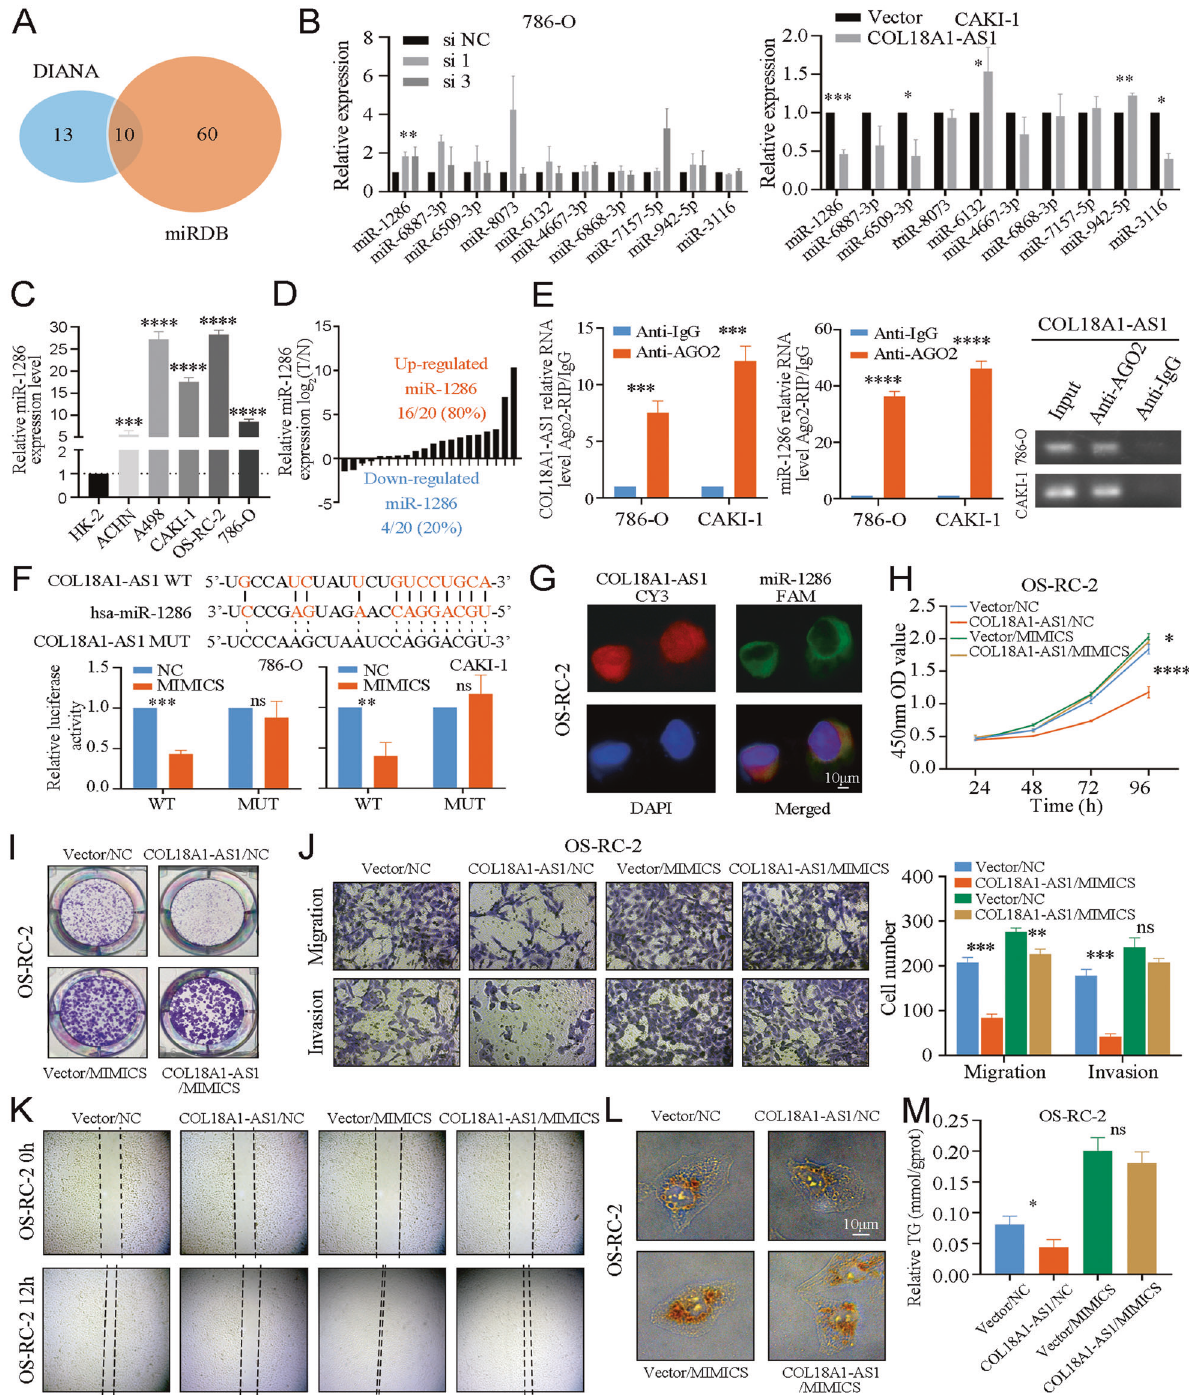
Fig. 4 COL18A1-AS1 interacted with miR-1286 in ccRCC. A A Venn diagram of two independent miRNA prediction analysis. Blue: DIANA database. Orange: miRDB database. B qRT-PCR results of expression level of candidate miRNAs in 786-O and CAKI-1 cells transfected with si- COL18A1-AS1 or COL18A1-AS1 vector. C The expression level of miR-1286 in RCC cell lines (ACHN, A498, CAKI-1, OS-RC-2, and 786-O) and normal cell line (HK-2). D The expression level of miR-1286 in 20 ccRCC tissues and adjacent normal tissues. E RIP assays showed the abundance of COL18A1-AS1 and miR-1286 in AGO2 complex in CAKI-1 and 786-O cells. F Luciferase reporter assays detected the luciferase activity of COL18A1-AS1-WT or COL18A1-AS1-Mut under miR-1286 MIMICS in CAKI-1 and 786-O cells. G Representative FISH images showed the co-localization of COL18A1-AS1 (red) and miR-1286 (green) in the cytoplasm of 786-O cells. Cell nuclear appear in blue (DAPI). Scale bars, 10 μ m. H , I Cell proliferation ability of OS-RC-2 cells co-transfected with COL18A1-AS1 vector and/or miR-1286 MIMICS was determined using CCK8 assays or colony formation assays. J , K Cell migration and invasion ability of OS-RC-2 cells was measured with Transwell assays or wound healing assays (Magni fi cation: ×100 for Transwell assays and x40 for wound healing assays). L Photomicrographs of Oil Red staining of OS-RC-2 cells. Scale bars, 10 μ m. M Relative TG (mmol/gprot) levels in OS-RC-2 cells assessed by a triglyceride assay kit. * P < 0.05, ** P < 0.01, *** P < 0.001, **** P < 0.0001. Error bars indicate mean ± SD. All the experiments were performed in triplicate.